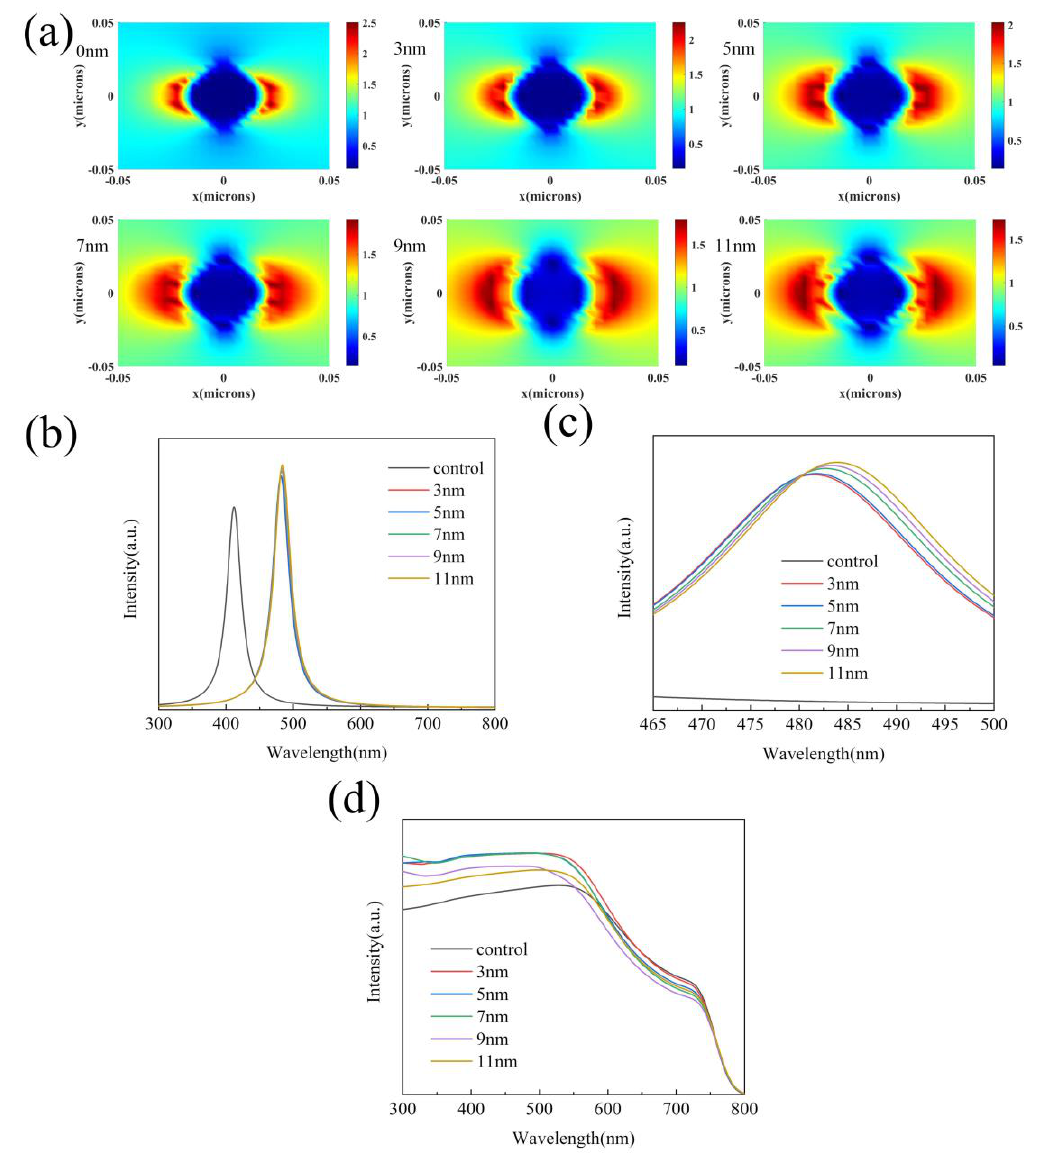
Figure 2. ( a ) Local field simulation of Ag@SiO 2 nanoparticles with a different shell thickness. ( b ) Scattering spectra of Ag@SiO 2 nanoparticles with a different shell thickness. ( c ) Local amplified scattering spectra of Ag@SiO 2 nanoparticles with a different shell thickness. ( d ) Light absorption spectrum of CH 3 NH 3 PbI 3 films with Ag@SiO 2 core-shell nanoparticles with a different shell thickness.